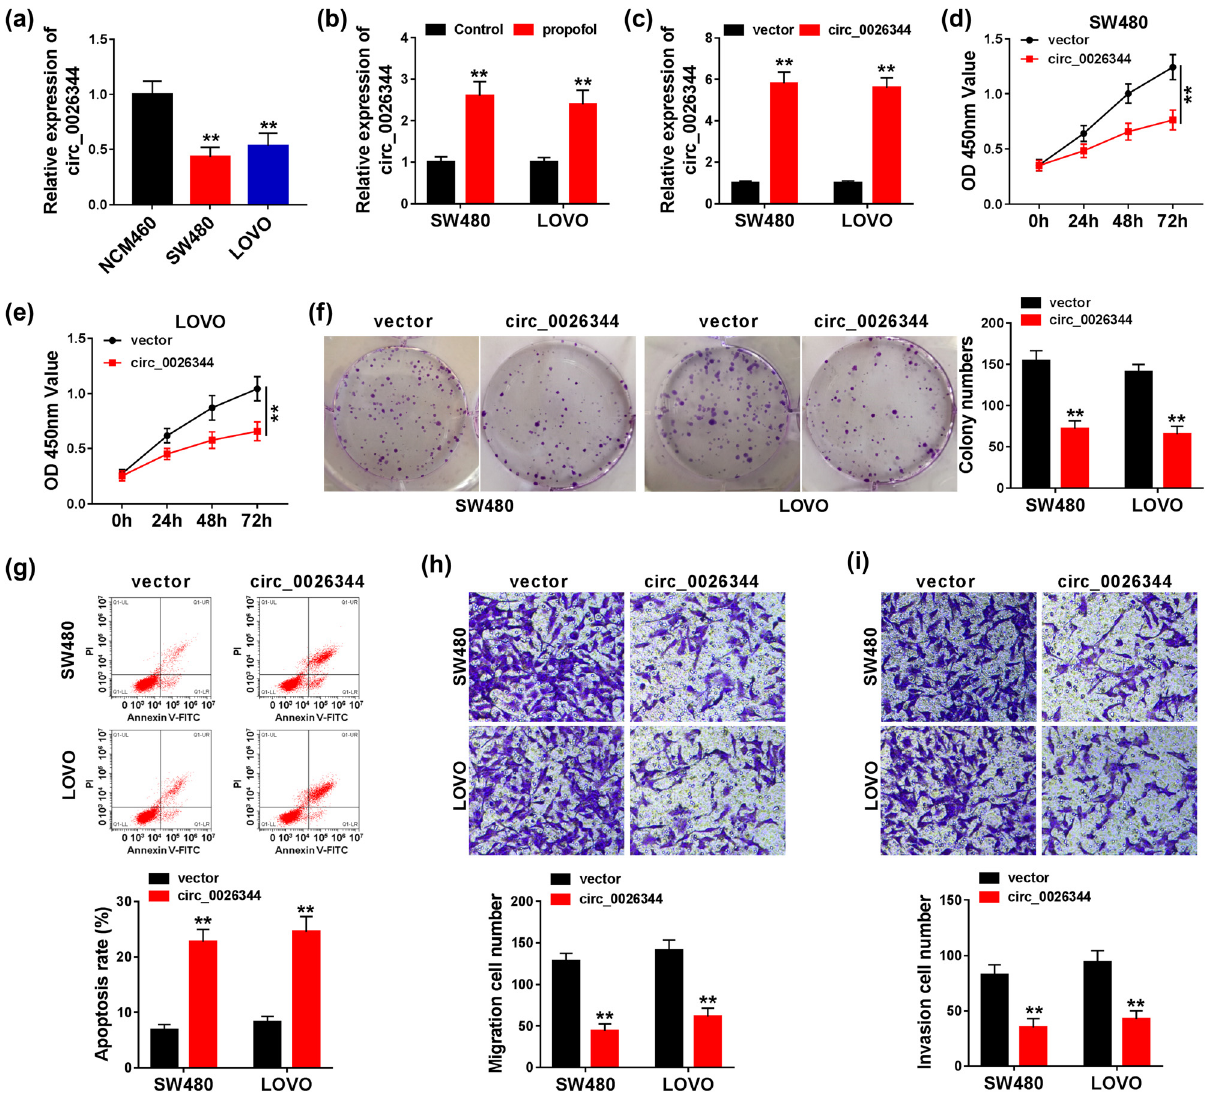
Figure 2: circ_0026344 overexpression inhibited CRC progression. ( a ) circ_0026344 expression was detected by qPCR in NCM460, SW480, and LOVO cells. ( b ) The e ff ect of propofol on circ_0026344 expression was determined by qPCR in SW480 and LOVO cells. ( c ) The transfection e ffi ciency of circ_0026344 was determined by qPCR in SW480 and LOVO cells. ( d – f ) The impact of circ_0026344 over - expression on cell proliferation was revealed by CCK8 and colony formation assays. ( g ) The impact of ectopic circ_0026344 expression on cell apoptosis was presented by fl ow cytometry assay. ( h and i ) The e ff ects of circ_0026344 overexpression on the migration and invasion of SW480 and LOVO cells were disclosed by transwell assay. Signi fi cant di ff erences were compared with Student ’ s t - test ( b – i ) or ANOVA ( A ) . ** P <